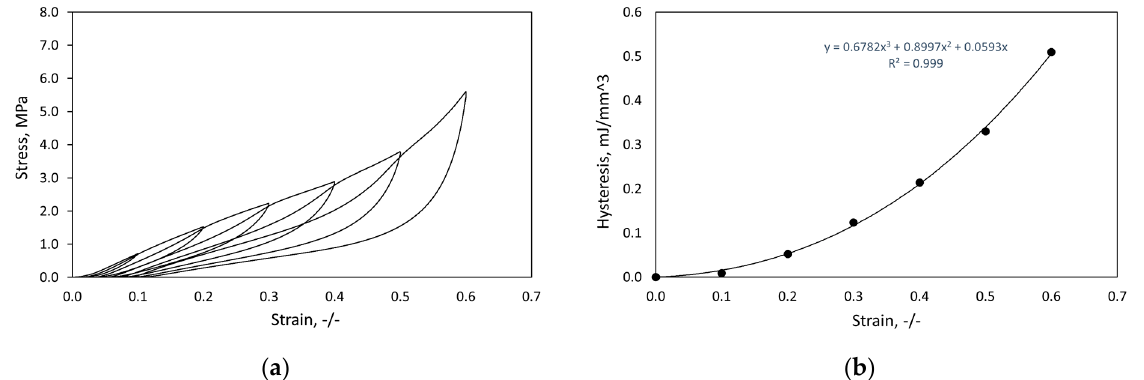
Figure 7. Mechanical properties of soft (75 Shore A hardness) TPE print: ( a ) stress vs. strain in compression test, ( b ) hysteresis vs. strain curve.